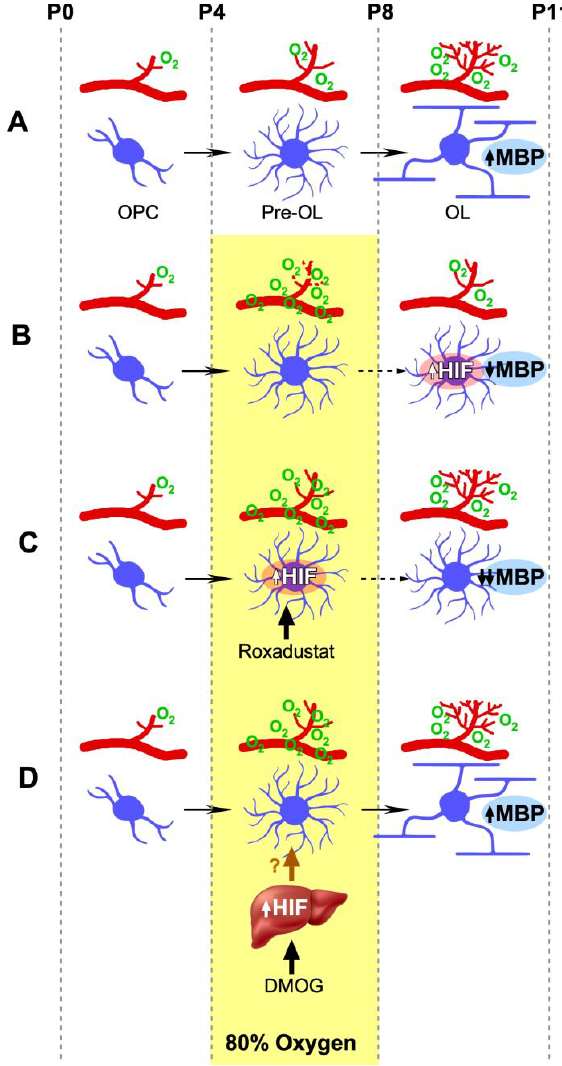
Figure 6 . Two-step hypothesis of the effect of oxygen on myelination. ( A ) Normoxia allows myelination by inducing normal capillary growth at postnatal day 4-postnatal day 8 (P4 – P8) to prevent hypoxia. Normal vascularization, in turn, downregulates HIF in premature oligodendrocytes (pre- OLs) allowing their transformation to mature myelinating oligodendrocytes (OLs). Myelination